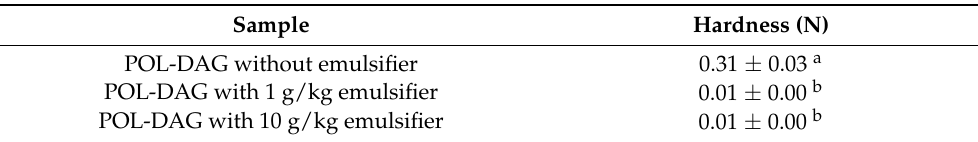
Table 2. Texture profile analysis of palm olein-based diacylglycerol (POL-DAG) oil with and with- out